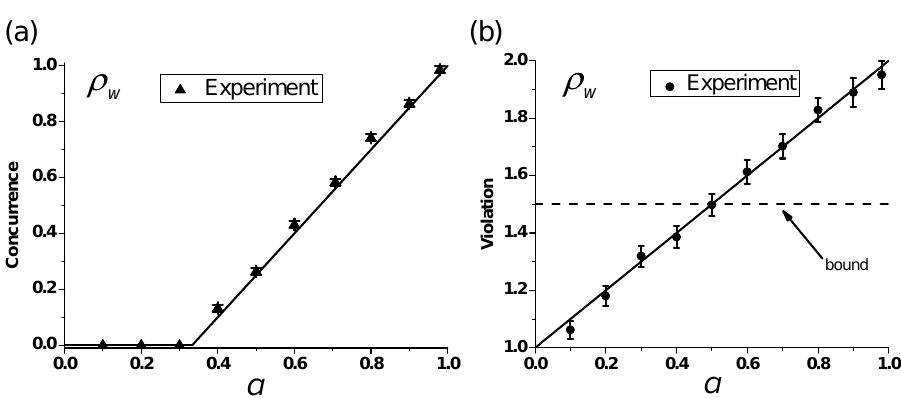
Figure 3. Experimental results of Werner states. ( a ) Experimental concurrence as a function of the decoherence coefficient a for different Werner states ρ w . The triangle symbols represent the experimental data. Solid line represents the theoretical prediction. Error bars are obtained based on assuming Poisson statistics. ( b ) Experimental violations of FGS inequality as a function of the state coefficient a . The circular symbols represent the experimental data. Solid line represents the theoretical prediction. Dashed line represents the bounds of violation of FGS inequality. Error bars are due to the statistical uncertainty. The experimental results match well with theoretical